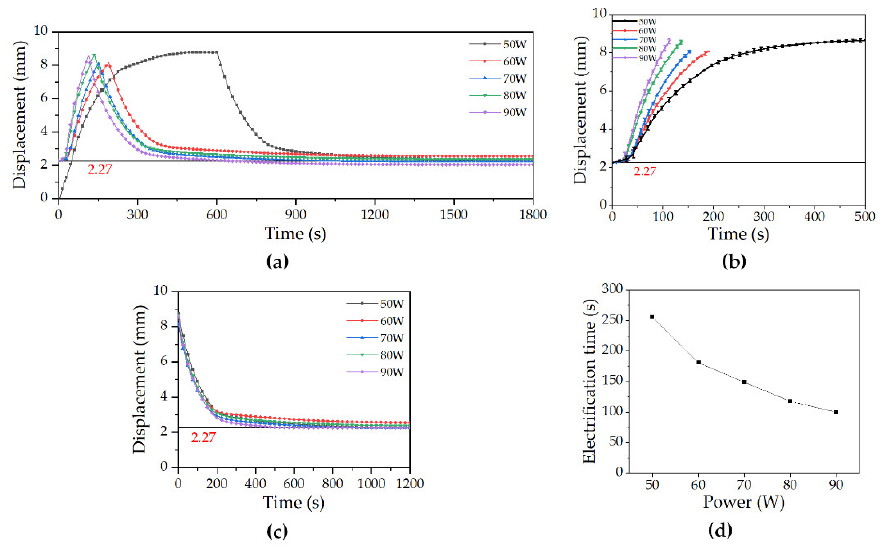
Figure 8. Experimental results of DDM underwater: ( a ) Displacement change monitoring of the DDM under different power, ( b ) displacement change monitoring of DDM running under different power, ( c ) displacement change data of the microunit during working withdrawal within 1200 s after stopping heating, and ( d ) response time of DDM underwater.